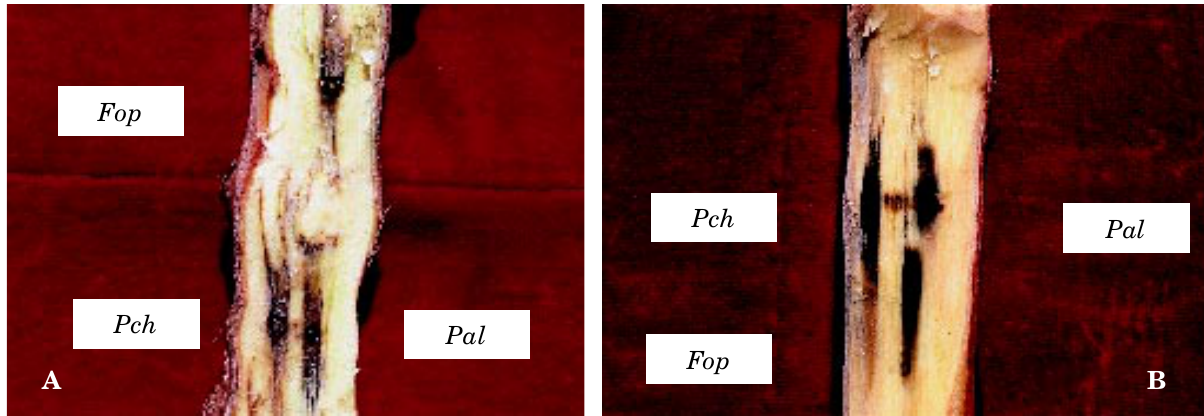
Fig. 2. A. A longitudinal section of a trunk of a 6-year-old grapevine cv. Italia, 8 months after inoculation with Fomitiporia punctata (up), Phaeoacremonium chlamydosporum (bottom, on the left) and P. aleophilum (bottom, on the right). The antagonistic effect of P. aleophilum vs. F. punctata did not allow the latter to cause a downward discoloration of the woody tissue. B. A longitudinal section of a branch of a 9-year-old grapevine cv. Matilde, 8 months after inoculation with F. punctata (bottom), P. chlamydosporum (up, on the left) and P. aleophilum (up, on the right); The brown wood discoloration caused by F. punctata was discontinued upward by the antagonistic effect of P. aleophilum, whereas P. chlamydosporum caused brown wood streaking in both